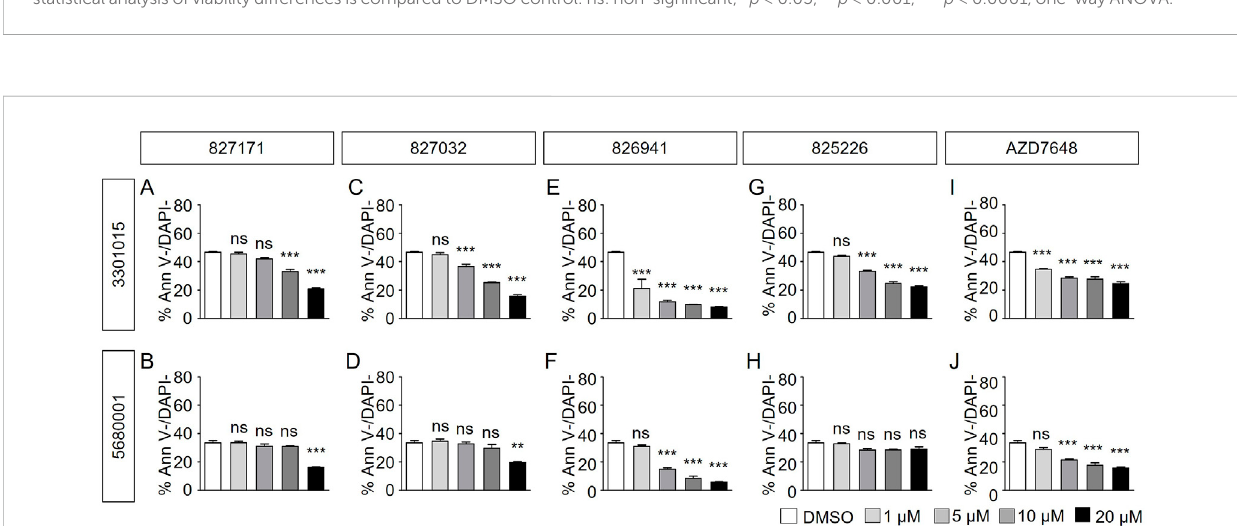
FIGURE 4 Artemis inhibitors and DNA-PK inhibitors effect on viability of normal mature B cell lines. Normal mature B cell lines 3301015 and 5680001 were treated for 3 days with 827171 (A, B) , 827032 (C, D) , 826941 (E, F) , 825226 (G, H) and DNA-PK inhibitor AZD7648 (I, J) with indicated concentrations. On day three, mature B cells were collected and used for fl ow cytometry analysis with PE Annexin V and DAPI to measure % viability (PE Annexin V-/DAPI-). The%viability(AnnV-/DAPI-)isdepicted.ThestatisticalanalysisofviabilitydifferencesiscomparedtoDMSOcontrol:ns:non-signi fi cant;* p < 0.05;